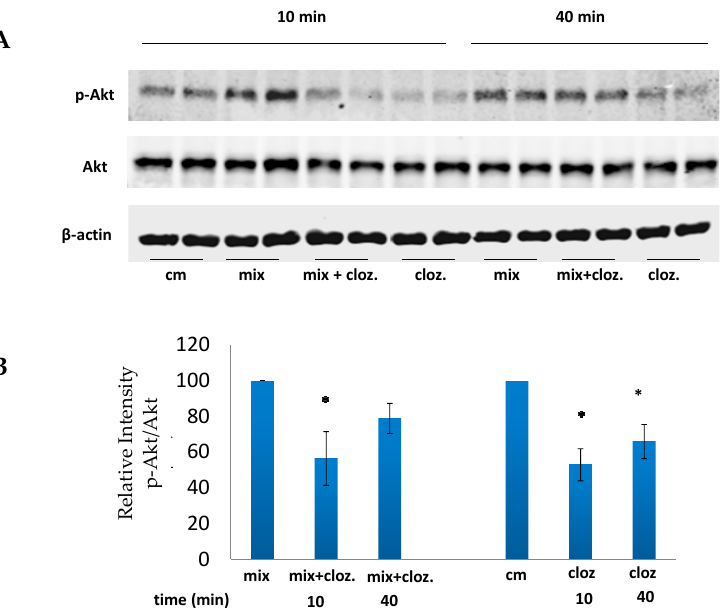
Figure 4. Effects of clozapine on Akt phosphorylation. ( A ) A172 cells were incubated with cytokine mix, or cytokine mix plus clozapine 10 µM or clozapine alone. Cytoplasmic extracts were prepared at the indicated times and subjected to Western immunoblotting with antibodies for the phosphorylated form of Akt (p-Akt-Thr-308). p-Akt = phosphorylated Akt; cm = control medium (i.e., medium alone); The blot is representative of one of three experiments with similar results. ( B ) Densitometric analysis of 3 independent experiments presented as relative intensity. The results are presented as mean ± SEM of 3 experiments (t= 2.84, df = 6, p < 0.05 for mix vs. mix +clozapine after 10 min; t = 5.06, df = 6, p < 0.01 for cm vs. clozapine after 10 min; t = 3.5, df = 4, p < 0.05 for cm vs. clozapine after 40 min). * p < 0.05 vs. mix or cm. To determine whether clozapine inhibition of Akt activation is involved in the up- regulation of COX2 expression, we examined the effect of the Akt inhibitor MK-2206 on COX2 gene expression in cells exposed to cytokine mix and to cytokine mix in the pres- Table 1. The immunomodulatory impact of clozapine on the astroglial cells—summary of major results. ence of clozapine. Pretreatment with MK-2206 and clozapine, 45 min before cytokine mix stimulation, increased COX2 mRNA beyond the increase caused by cytokine mix in the Inflammatory presence of clozapine alone. Moreover, pretreatment with MK-2206 alone of cells stimu- lated with cytokine mix, increased COX2 expression significantly (Figure 5). These re- sults indicate that Akt inhibition by clozapine may be involved in the increase in COX2 expression. MK-2206 and clozapine alone did not affect COX2 expression (data not shown).